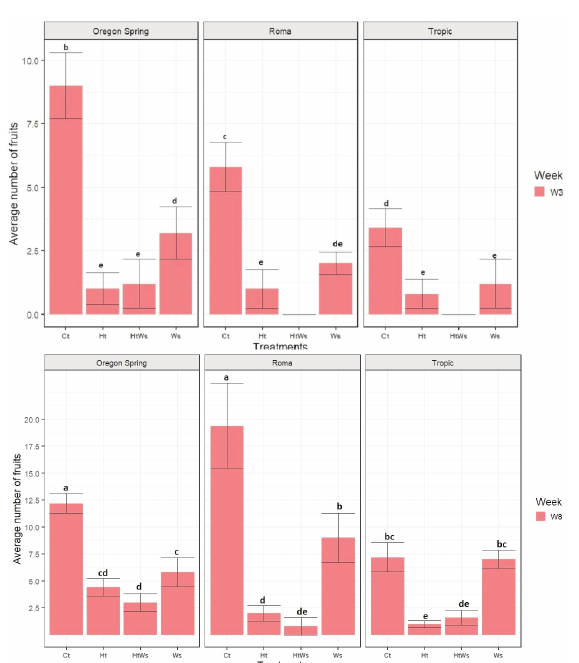
Fig. 6 ­ Average number of fruits per plant for the three tomato varieties (Oregon Spring, Roma and Tropic). The treat­ ments consist of Control (Ct), Water stress (Ws), Heat + Water stress (HtWs) and Heat (Ht). W3 and W8 = weeks of treatments imposition with measurements. Bars with the same letter are not significantly different at P<0.05 according to Turkey's test.